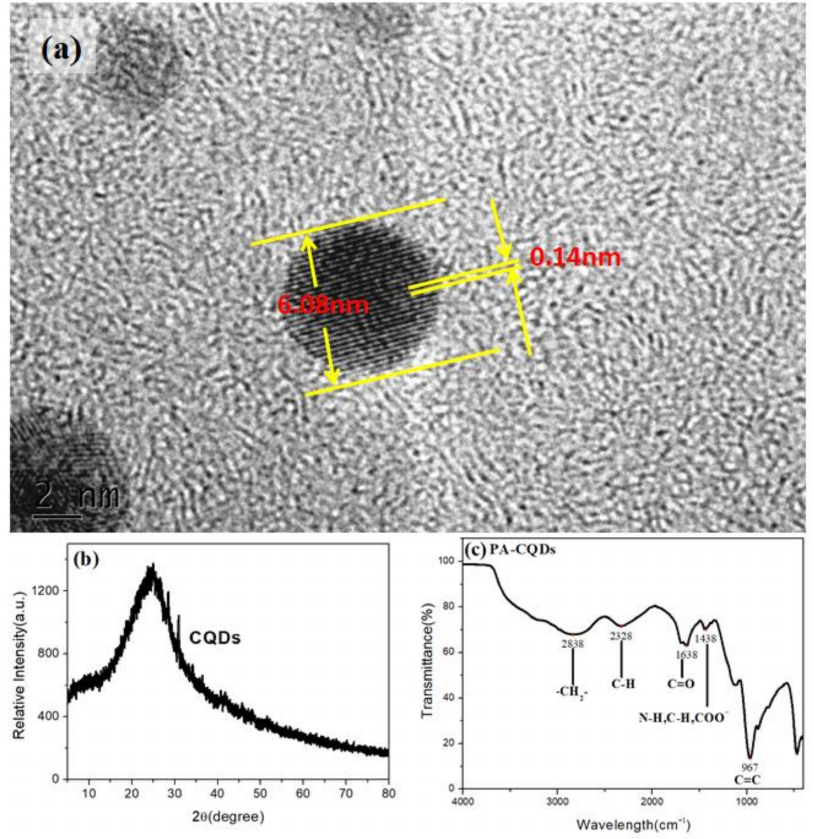
Figure 5. ( a ) TEM, ( b ) crystal structure, and ( c ) FTIR spectrum of